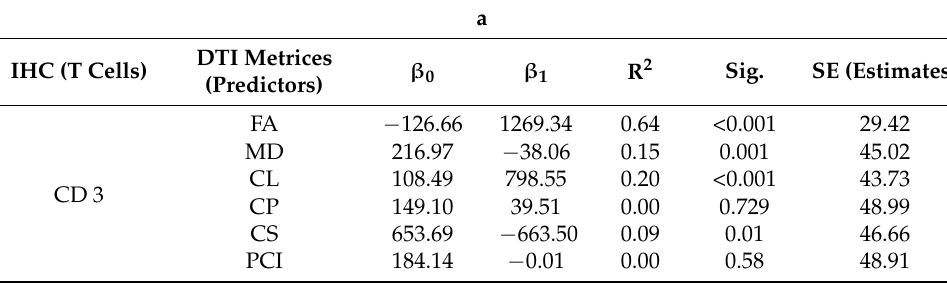
Table 6. (a). Linear regression models ( n = 80) with T lymphocyte population infiltration in the synovium. (b). Linear regression models ( n = 80) with B lymphocyte and plasma cells infiltration in the synovium. (c). Linear regression models ( n = 80) with macrophages and other inflammatory cytokines infiltration in the